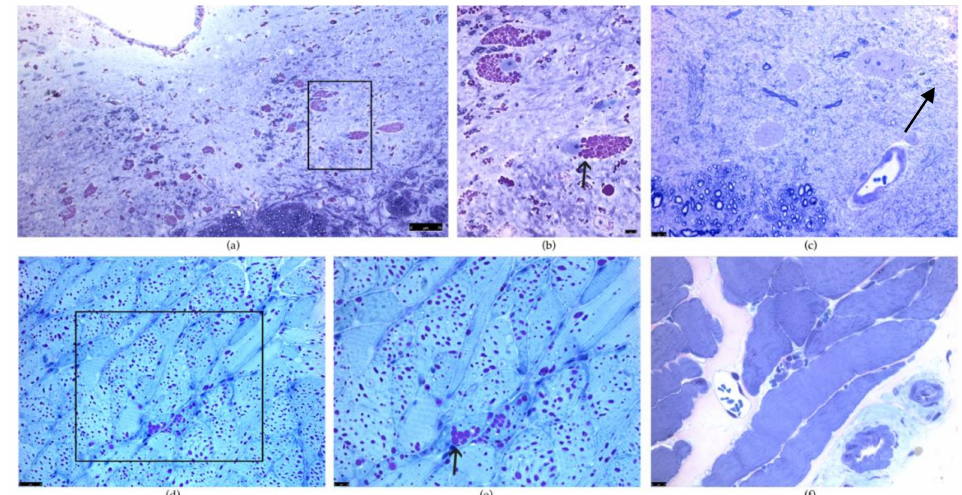
Figure 2. Periodic acid–Schi ff (PAS) staining of the hypoglossal motor neurons and the tongue in Gaa − / − and wild type (WT) mice. ( a , b ): PAS staining is positive in the hypoglossal motor nucleus in Gaa − / − mice. ( b ) is a higher magnification of the boxed region ( a ) and illustrates PAS positive vacuoles indicative of glycogen-filled lysosomes in the hypoglossal motor neurons. Note the disruption in the architecture of the motor neuron resulting in displacement of the nuclei (arrow). ( c ) illustrates PAS staining in a WT mouse at the same magnification as ( b ). Note the lack of positive PAS staining in the XII motor neuron and the centrally placed nuclei (arrow). ( d , e ): PAS staining of a Gaa − / − tongue illustrates vacuoles filled with PAS positive glycogen (arrow). ( d ) is a higher magnification of the boxed region ( d ). ( f ): PAS staining of a WT tongue shows striated muscle with no evidence of PAS positive vacuoles. ( f ) is the same magnification as ( e ). Scale bars lower right in ( a , b ); lower left corner in ( c , d , e , f ). The scale bar denotes 7 µ m in ( a ), 10 µ m in ( b , c , e , f ), and 25 µ m in ( d